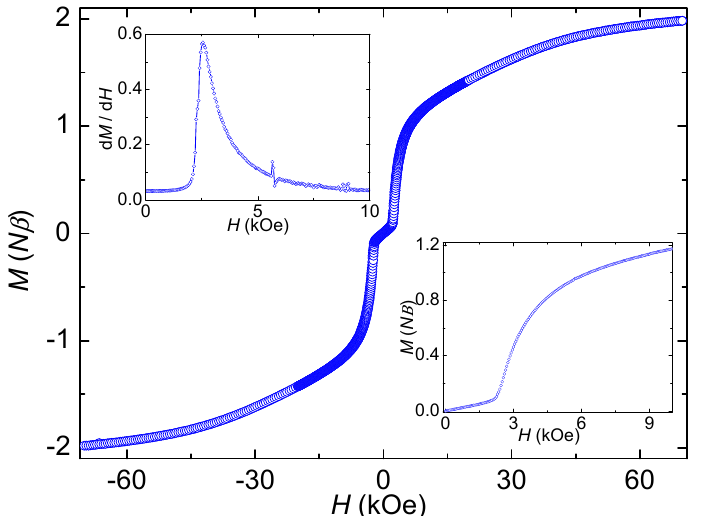
Figure 5. The isothermal field-dependent magnetization of 1 at 1.8 K. Insets: The low-field M - H and dM/dH plots.